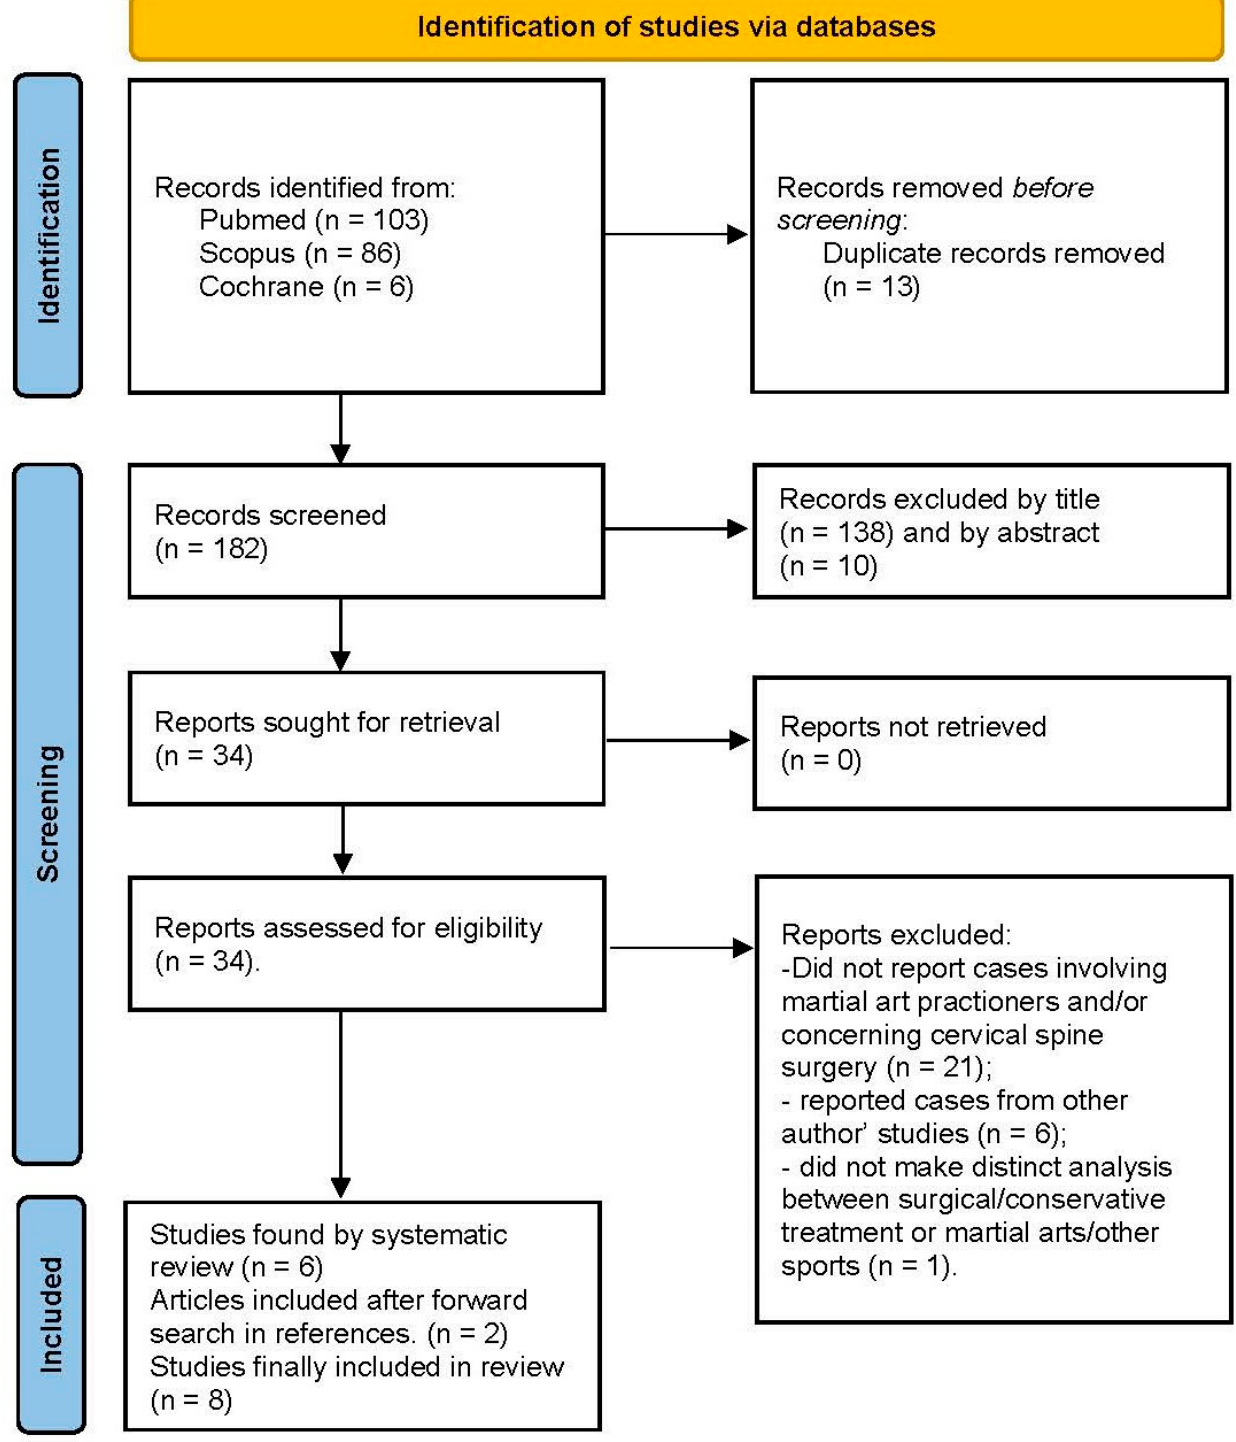
Figure 1. Box diagram showing the article selection process of the systematic literature review.